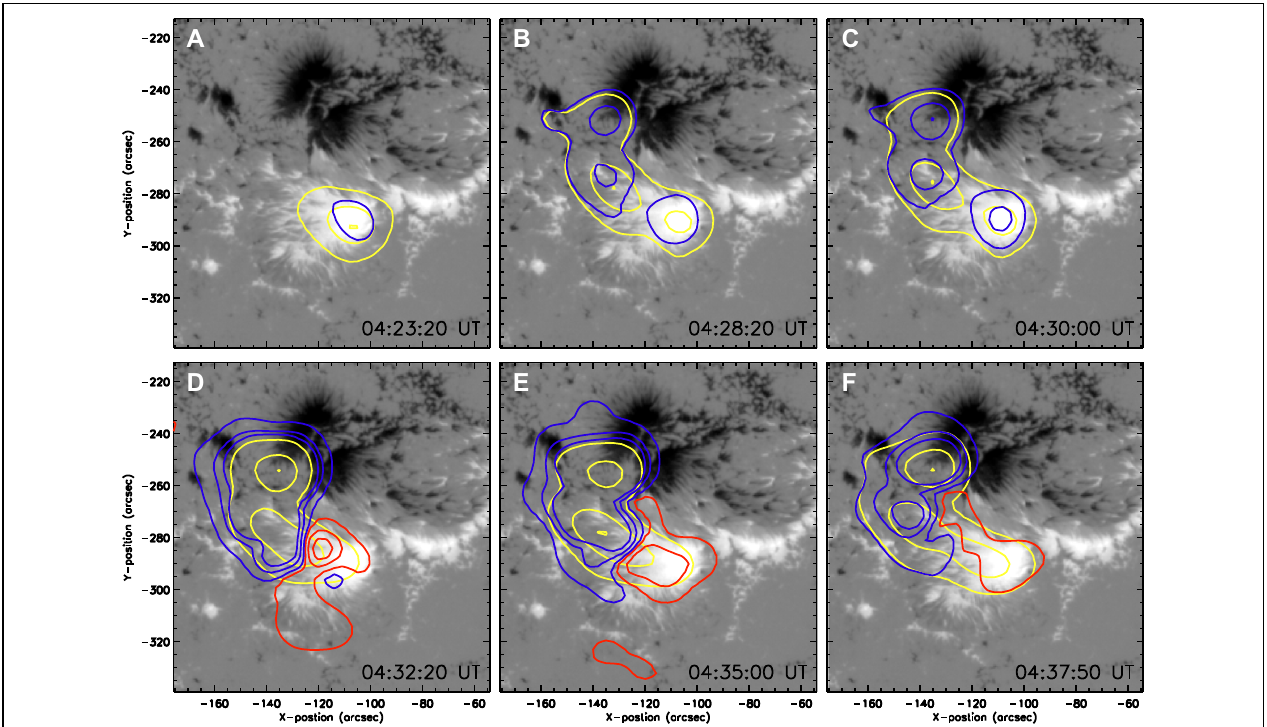
FIGURE 3 | Total and polarized microwave emissions plotted over the HMI line-of-sight magnetograms. The 17 GHz total intensity (yellow contours) is plotted at [10, 50, 100]% of its maximum at each time. The polarized intensity in LHCP (RHCP) are plotted in blue (red) contours in absolute levels, [10, 50, 100]% of ±2.3 MK. In the preflare phase, all sources are LHCP (A–C) , while the region over the central spot becomes RHCP during the impulsive phase (D) and remains so during the decay phase (E, F) . (Source: Lee et al., 2020b).